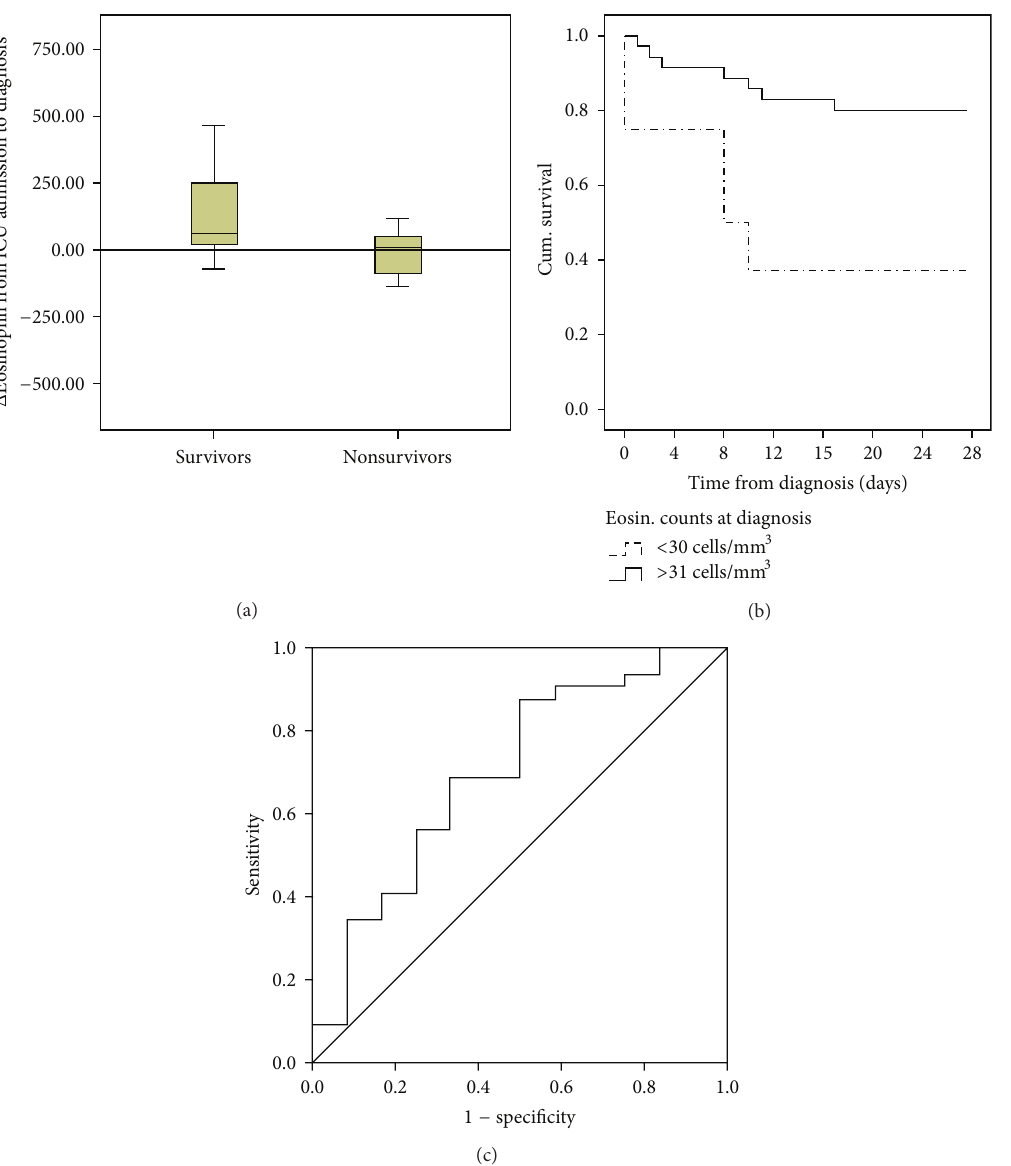
Figure 1: (a) Box plots showing increments of eosinophil counts: [counts at VAP diagnosis]–[counts at ICU admission] ( 𝑃 = 0.016 ). (b) Kaplan Meier curves for survival: deciles from percentile 10 to percentile 90 of eosinophil counts were calculated and used to compare survival times in those patients with low or high counts. The first decile showing significant differences between groups based upon the log-rank test was used as the cutoff (percentile 20). Time was censored at 28 days following VAP diagnosis. Cum. survival: cumulative survival. (c) AUROC analysis: the accuracy and the predictive values of eosinophil counts for detecting survivors in the first 28 days following VAP diagnosis were assessed calculating the